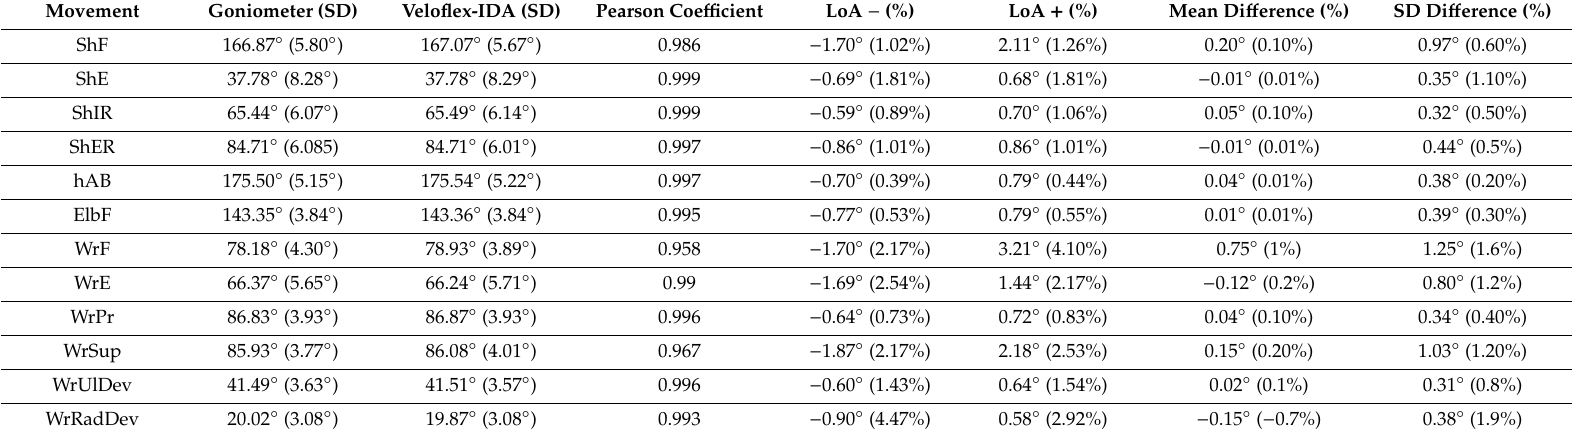
Table 2. Validity between Veloflex-IDA and goniometer to measure the range of motion of the upper limb